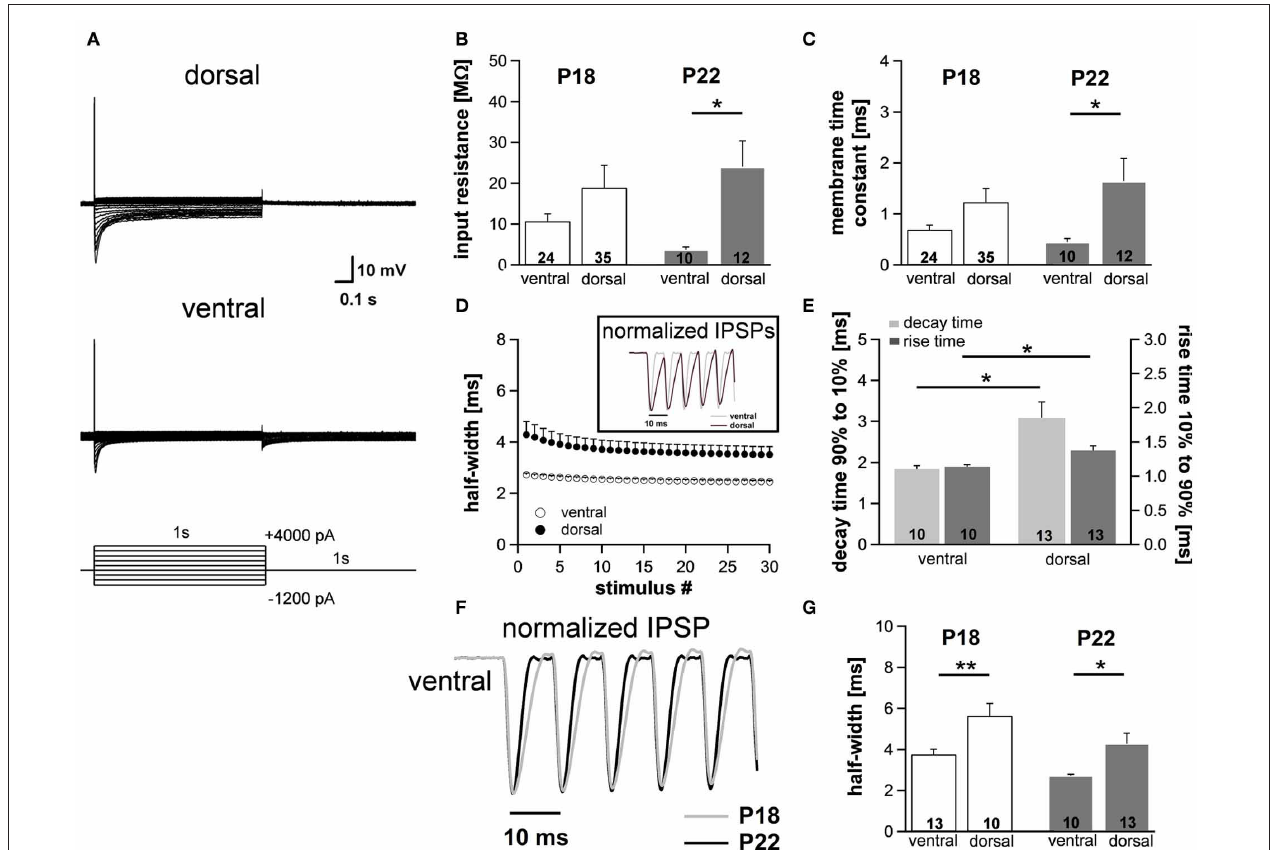
FIGURE 6 | Differences in membrane properties are more evident in mature animals. (A) MSO neurons in the dorsal and in the ventral part of the MSO fire a single spike at the onset of depolarizing current injections and exhibit a voltage sag during hyperpolarizing current steps. In particular, in ventral neurons the voltage sag only is obvious for strong hyperpolarizing current injections due to the large resting conductance of I h . (B) Peak input resistance and (C) membrane time constant vary significantly between ventral ( n = 10) and dorsal ( n = 12) neurons. Differences in the input resistance and in the membrane time constant between ventral and dorsal neurons are significantly larger in P22 animals compared with P18 animals.